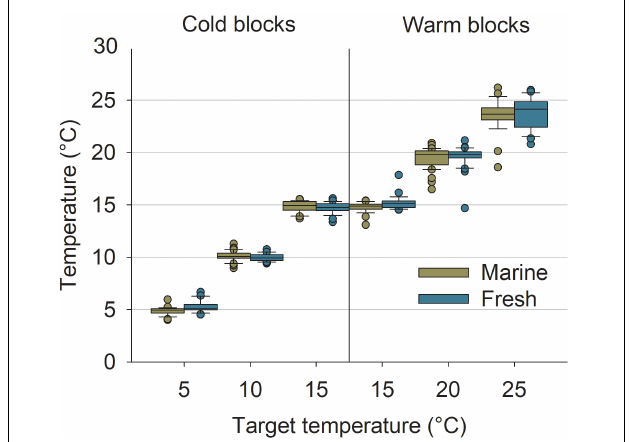
FIGURE 4 | Measured temperatures in the experimental tanks in relation to the different target combinations of temperature and salinity. Replicates represent the mean temperature of a phase (i.e., Acclimatization B, Exposure, or Recovery). Boxes represent 25th and 75th percentiles, lines show median, error bars show 5th and 95th percentile, and dots show outliers.